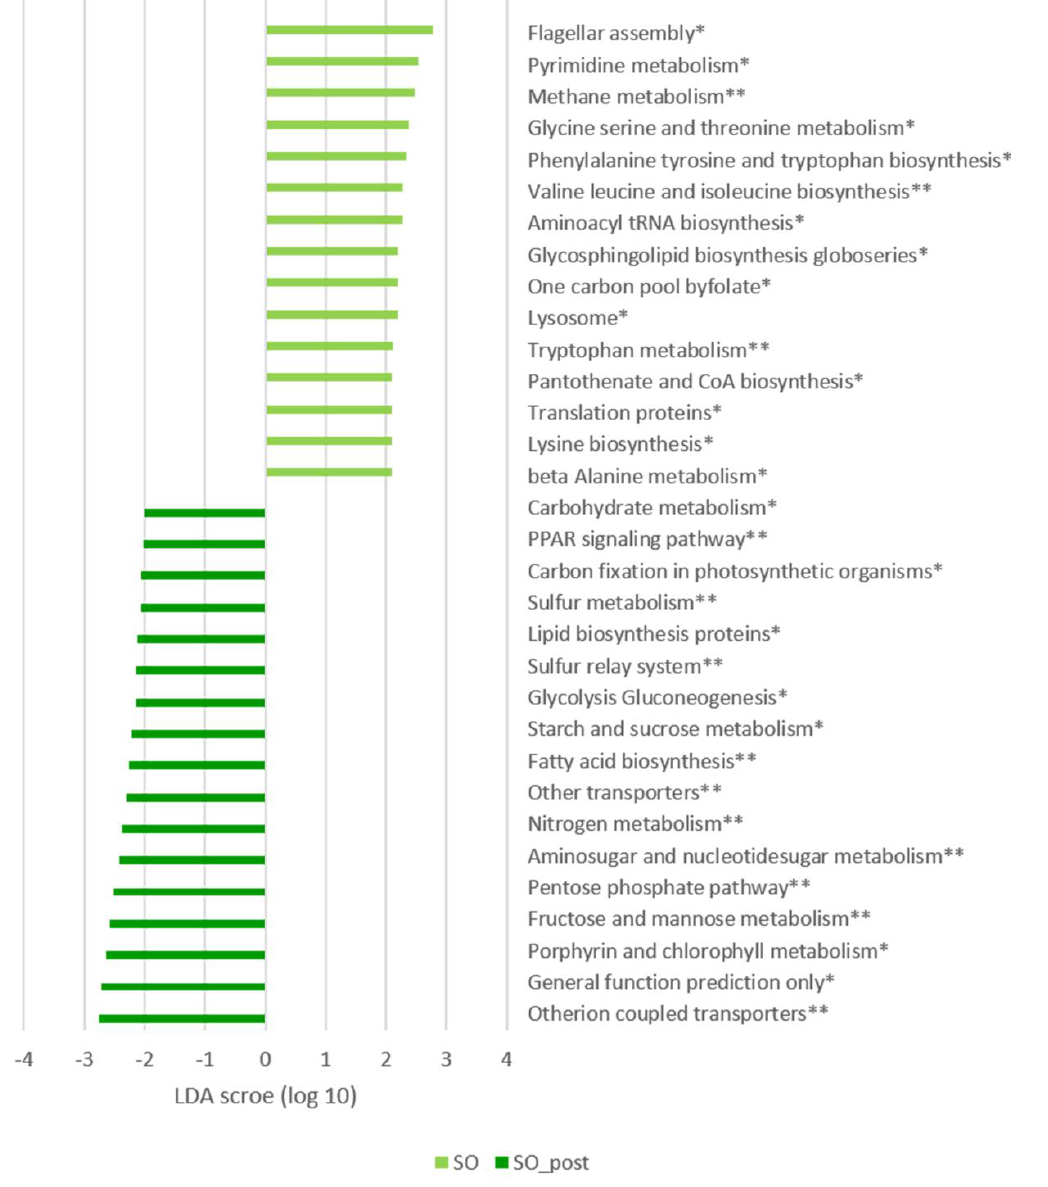
Figure 5. LDA scores of differently abundant inferred gut microbial metabolic pathways preceding and following SOE supplementation. Predicted microbial functions were inferred by PICRUSt from 16S rRNA gene sequences, which were assigned by closed reference OTU picking method. SOE mice preceding (light green) and following (dark green) the supplementation, were compared by LEfSe analysis of KEGG based on level 3 pathways. Only pathways meeting LDA ≥ 2.5 and p < 0.05 are shown. * p < 0.01, ** p < 0.005.